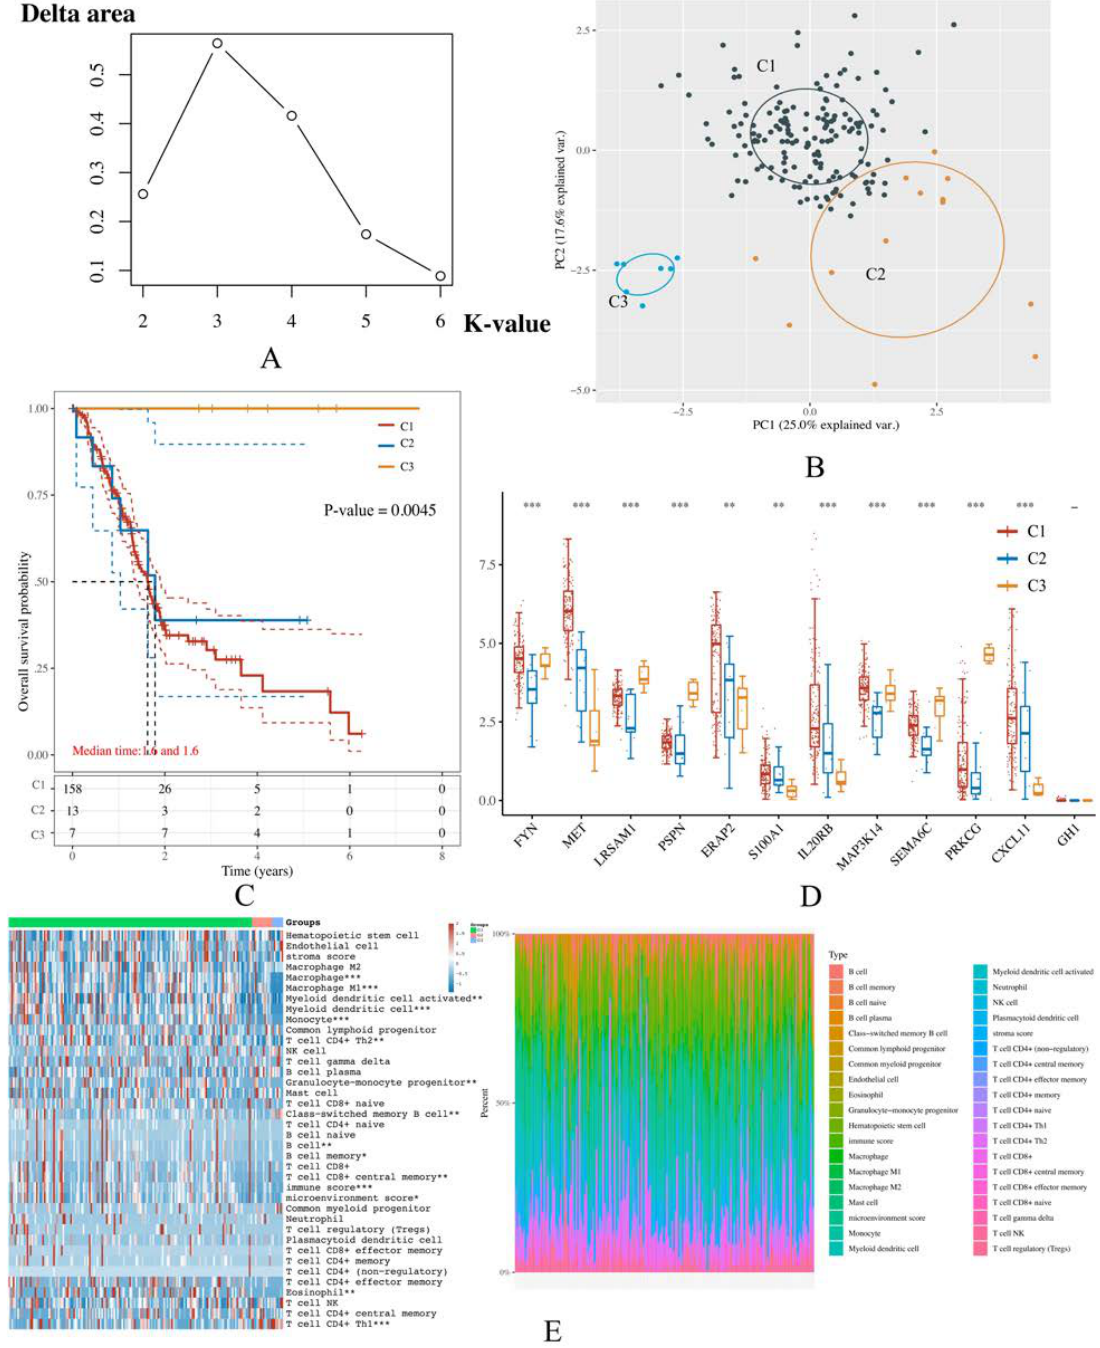
Figure 7. Clustering results for IRGPI-based molecular subtypes. Three molecular subtypes with optimal consensus values were identified and annotated as C1-3. ( A ) The delta area diagrams demonstrate the result of clustering through the K-means algorithm, upon which the most ideal K-value is 3. Therefore, 3 molecular subtypes were deemed most appropriate to be established according to the IRGPI. ( B ) The principal component analysis (PCA), in which the more widely separated each subtype is, the more ideal the consensus clustering result is achieved. As shown in this panel, 3 subtypes were well separated, once again indicating that clustering the samples in this way is suitable. ( C ) The Kaplan Meier (KM) curve of the 3 molecular subtypes is annotated as C1-3. ( D ) The comparison of the IRGPI genes’ expression level between each molecular subtype. ( E ) The heatmap demonstrates different immune-related scores of each molecular subtype on the left and exhibits the abundance of each immune cell type on the right. The x -axis represents the TCGA samples involved in the